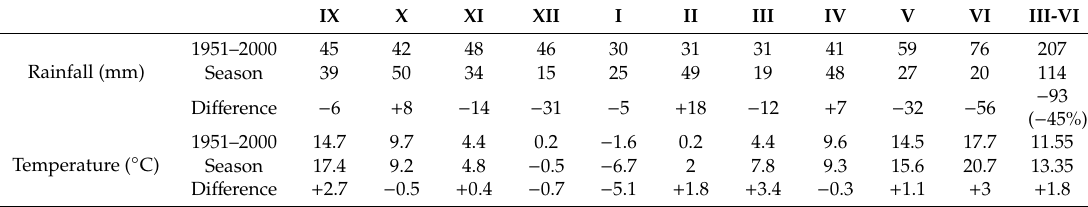
Table 1. Average monthly total precipitation (mm) and air temperature ( ◦ C) measured in location (Piešt’any) in individual months of the growing season and the period 1951–2000 (long-term